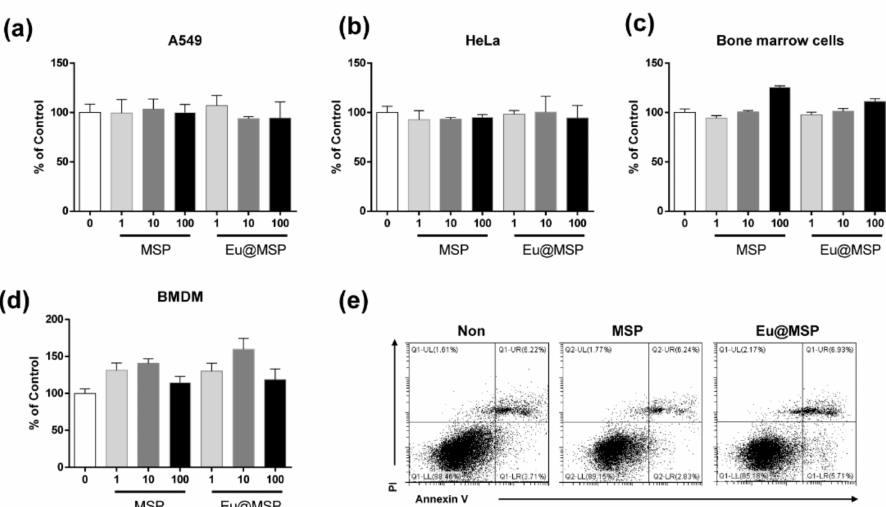
Figure 6. Cytotoxicity of MSP and Eu@MSP to A549, HeLa, mouse bone marrow cells and mouse bone marrow-derived macrophage. ( a ) A549 ( b ) HeLa ( c ) mouse bone marrow cells and ( d ) BMDMs were plated in 96-well culture plates (1 × 10 4 cells/well). After 24 h, the cells were incubated with 1, 10, and 100 µ g/mL of MSP and Eu@MSP, respectively, for 24 h. Cytotoxicity was evaluated using CCK-8 as described in the Materials and Methods section (n.s, no significant). ( e ) Detection of BMDMs cell death assessed by flow cytometry using FITC-Annexin V and PI double immunostaining. BMDMs were untreated, treated with MSP and Eu@MSP for 24